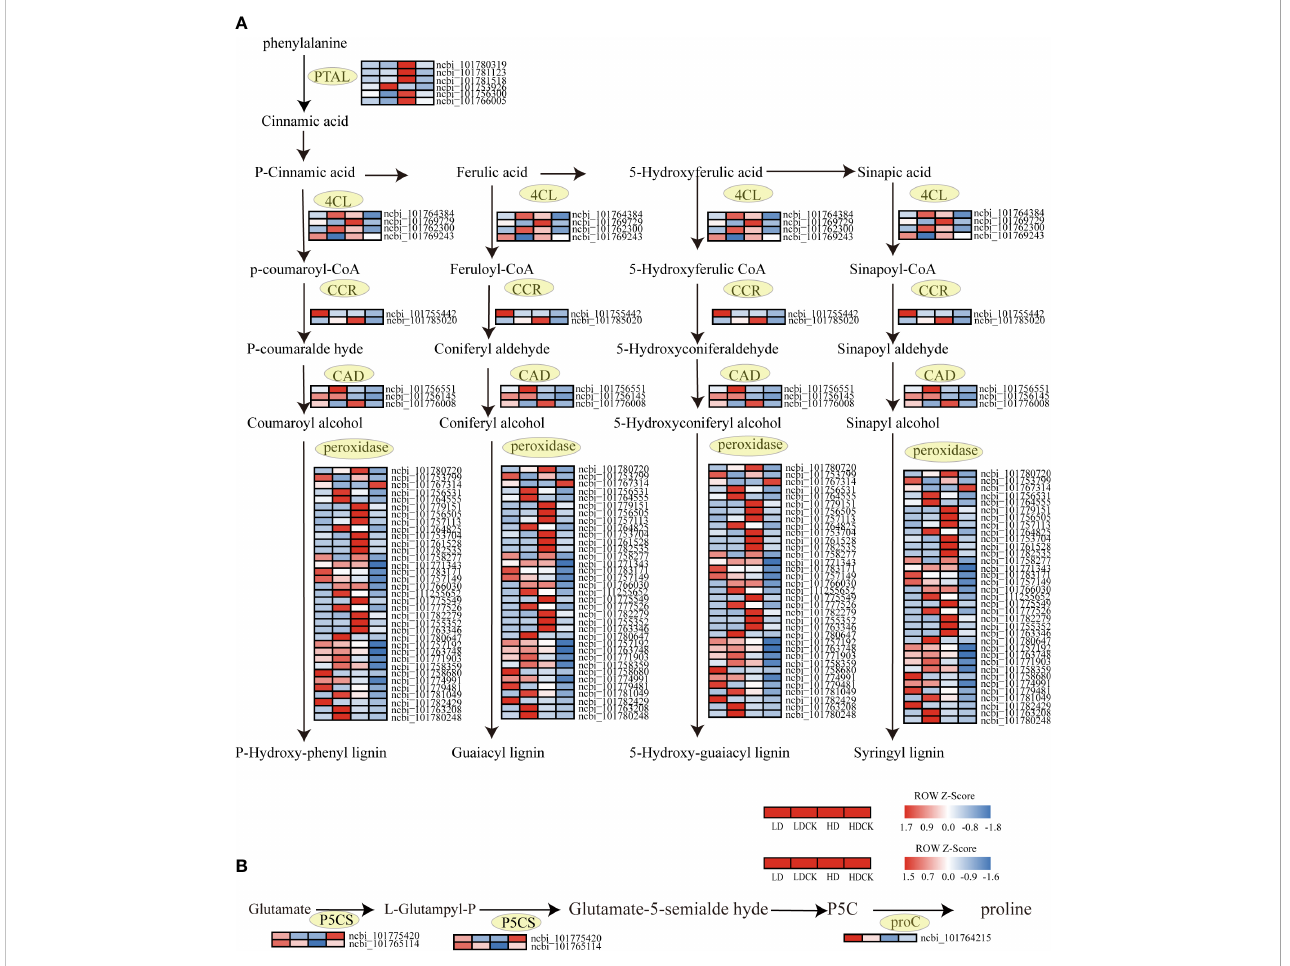
FIGURE 8 Lignin synthesis, changes in proline synthesis genes under drought stress. The color patch represents the FPKM value. Red and blue indicate Signi fi cant upward and downward revisions Gene (log 2 |fold-change| ≥ 1). (A) Heat map of drought response DEGs involved in lignin synthesis pathways under drought stress. (B) Heat map of drought response DEGs involved in proline synthesis pathways under drought